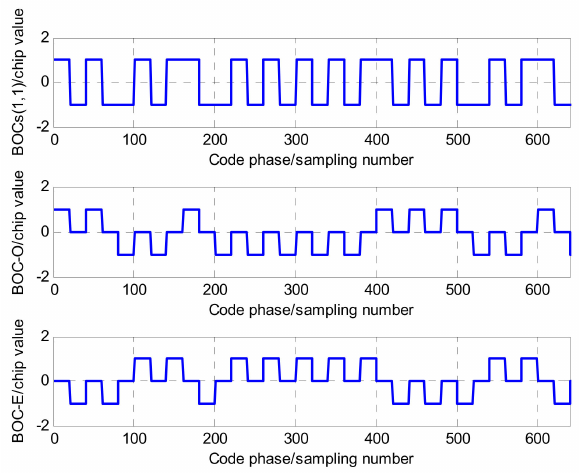
Figure 6. The separation of the BOCs(1,1) sequence.